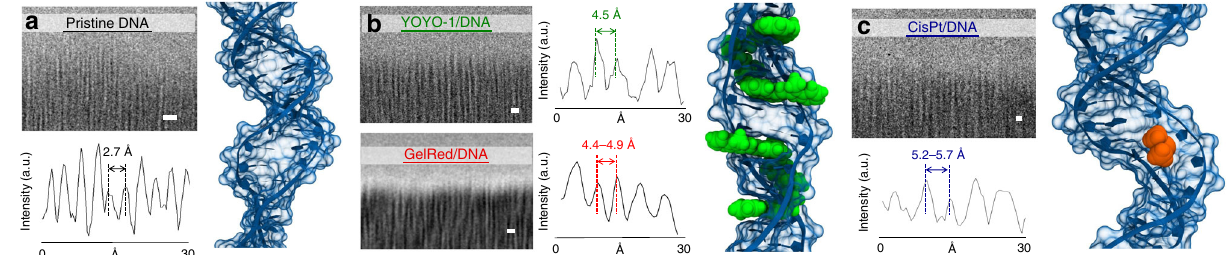
Fig. 2 HRTEM images, related metrology, and schemes. Interbase distance details of a pristine DNA bundle ( a ), DNA bundle with bis-intercalators ( b ), and DNA with CisPt adducts ( c ). The DNA interbase distance changes from 2.7 Å in the pristine DNA conformation to ~4.5 Å and 5.2 Å in the DNA altered by the presence of intercalant molecules or CisPt, respectively. The scale bars correspond to 10 Å. Notice that for panels b and c , the models are just an indication of the action of each intercalant molecule and the changes of the periods are not reported